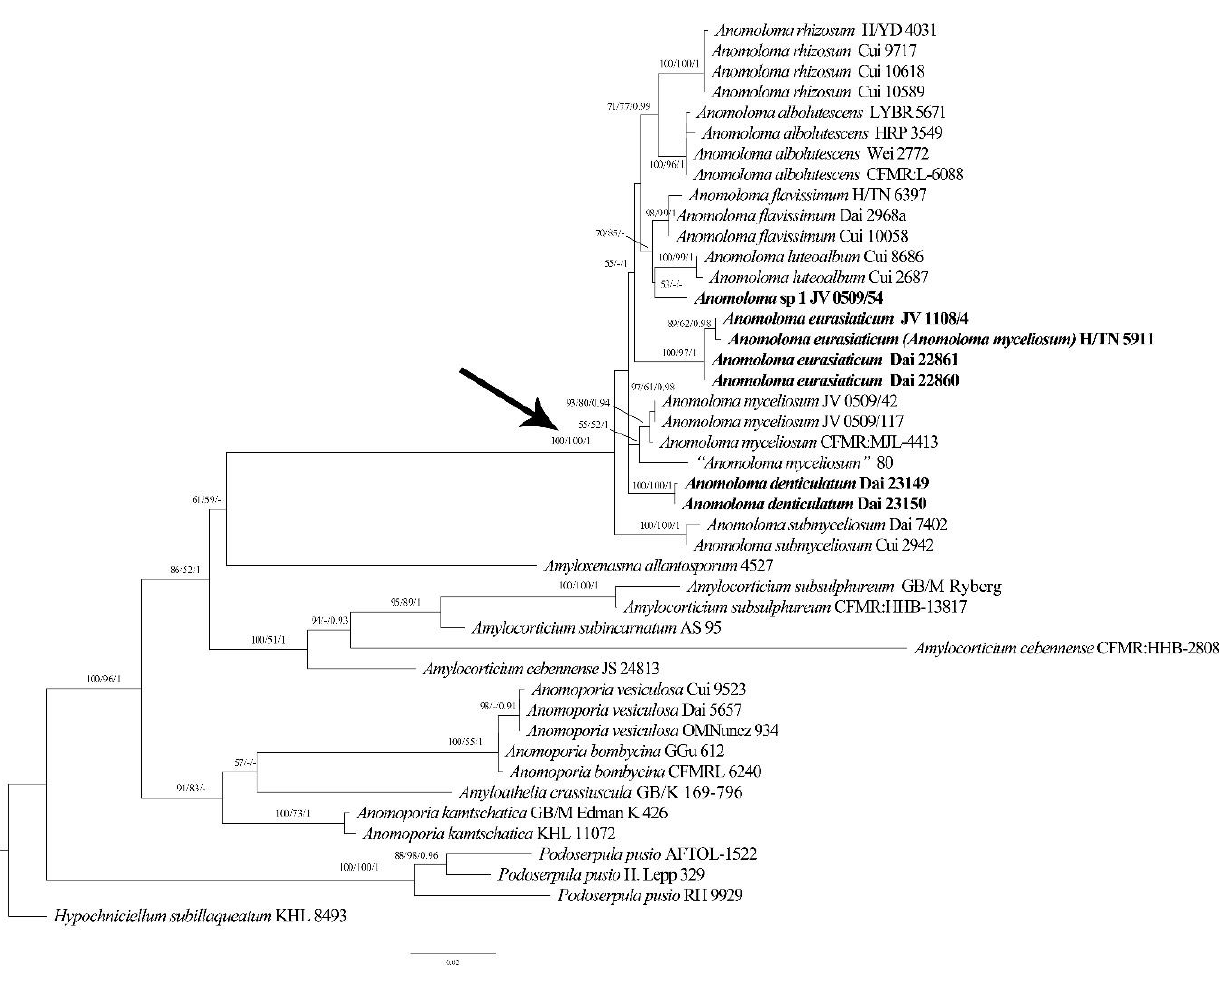
Figure 1. Maximum likelihood phylogenetic tree of Anomoloma species on the basis of ITS + LSU dataset. Branches are labeled with bootstrap values (MP/ML) >50%, and posterior probabilities (BI) > 0.90 respectively. New taxa are in bold. An arrow pointed the Anomoloma clade.